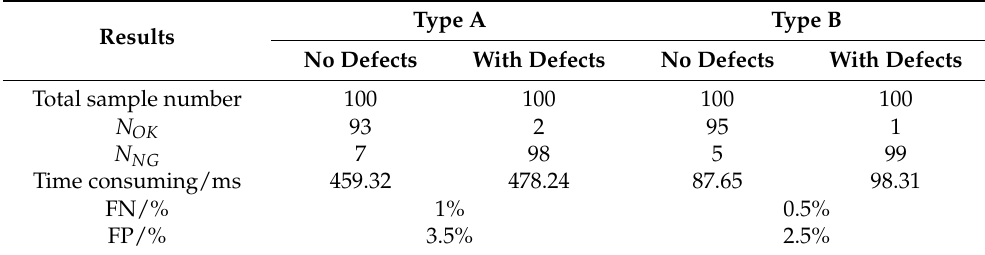
Table 2. Experimental